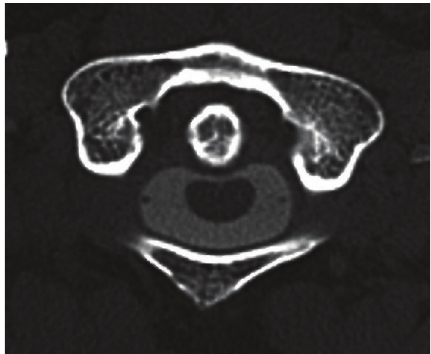
Figure 2: CT images after myelography. An increased ADI was apparent without evidence of fracture at the attachment site of the transverse ligament.